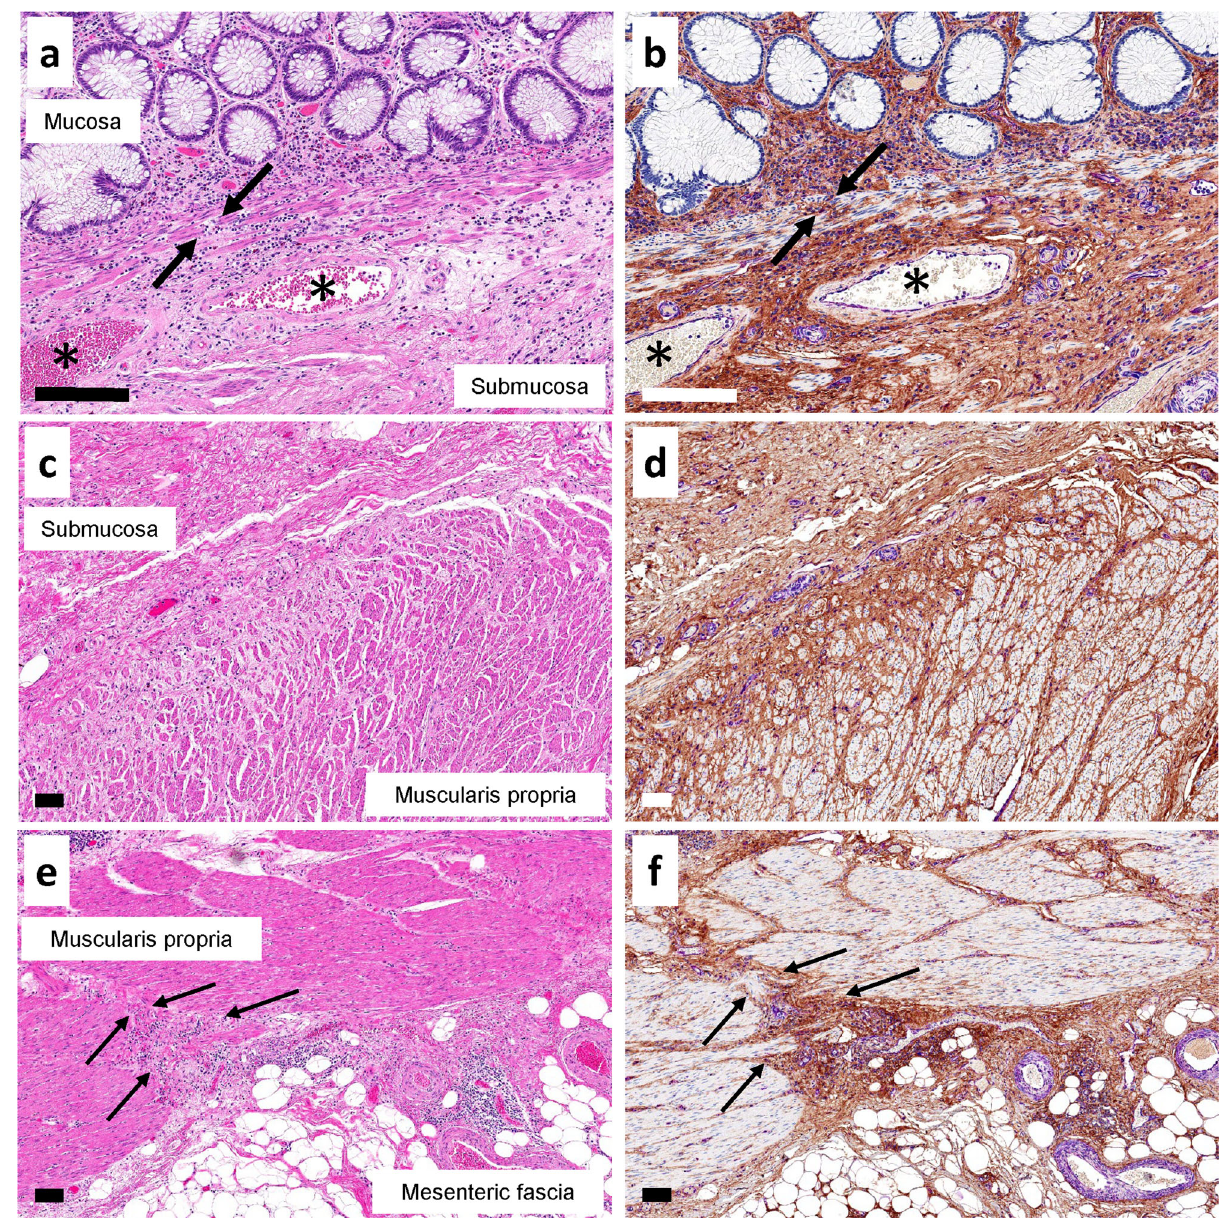
Fig. 4 HA staining in interstitial spaces is continuous through all the layers of the colon into mesenteric soft tissues. Adjacent colon samples were stained with H&E (left) and a triplex chromogenic assay (right) for HABP (brown), vimentin (magenta), and CD34 (teal). a , b Juncture of lamina propria to the submucosa, with channels observed through the muscularis mucosae (black arrows). There is continuity between all these layers by HA staining (right). * marks large veins in submucosa with HA staining showing continuity between perivascular stroma and the surrounding submucosal stroma. (×40 magni fi cation). c , d Juncture between colonic submucosa and the muscularis propria. HA staining shows the continuity of HA- fi lled interstitial spaces from submucosa through small pericapillary channels between muscle bundles of the muscularis propria (right). (×10 magni fi cation). e , f Edge of the fi brovascular bundle (arrows) passing between colonic wall, through muscularis propria, into subserosa and mesenteric fascia (right). In all multiplex- stained images, staining is as in Fig. 5. Scale bars = 100 μ glycosaminoglycans of the interstitium 21 . Given that the esti- surgical segmental colectomy specimens performed for the treatment of malignant polyps ( fi ve patients; Table 1), all of which contained tattoo pigment (India ink) mated volume of interstitial fl uid in the body is more than three that was injected according to standard techniques via a standard colonoscopy times the combined fl uid volume of the cardiovascular and injection needle into the colonic submucosa adjacent to the lesion at the time of lymphatic systems 38 , the existence of an interconnected inter- colonoscopy and prior to surgery. In each case, tissue from the tattoo site (middle stitial compartment suggests an anatomic basis for understanding of the specimen) and the normal distal or proximal surgical margin (whichever was furthest from the lesion) were examined for a total of ten specimens. Sections of both physiological processes and disease pathophysiology. normal skin were obtained from reduction mammoplasty specimens ( fi ve patients). Skin punch biopsy specimens were studied, including samples which included cosmetic tattoos (three patients) and two skin punch biopsy specimens containing colloidal silver in a single patient with argyria after topical skin application of colloidal silver. Sections of normal liver consisted of histologically normal liver